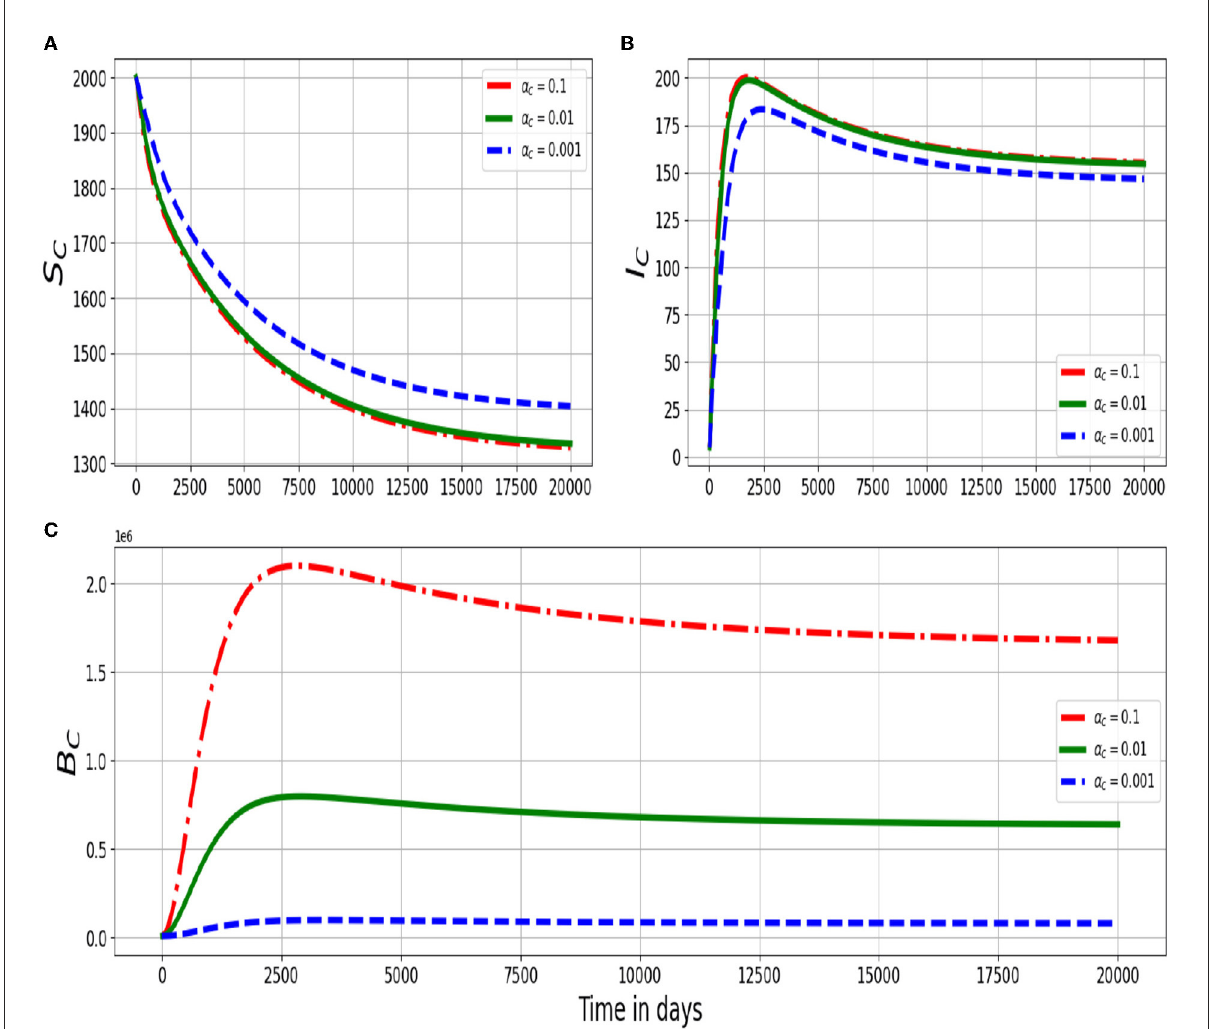
FIGURE3 Graphs of numerical solutions of the multiscale model system (2.4) showing the evolution in time of (A) population of susceptible ruminants ( S C ), (B) population of infected ruminants ( I C ), and (C) between-host MAP bacterial load ( B C ) for different values of excretion rate of the within-host MAP bacterial load into the environment α c : α c = 0.1, α c = 0.01, and α c =